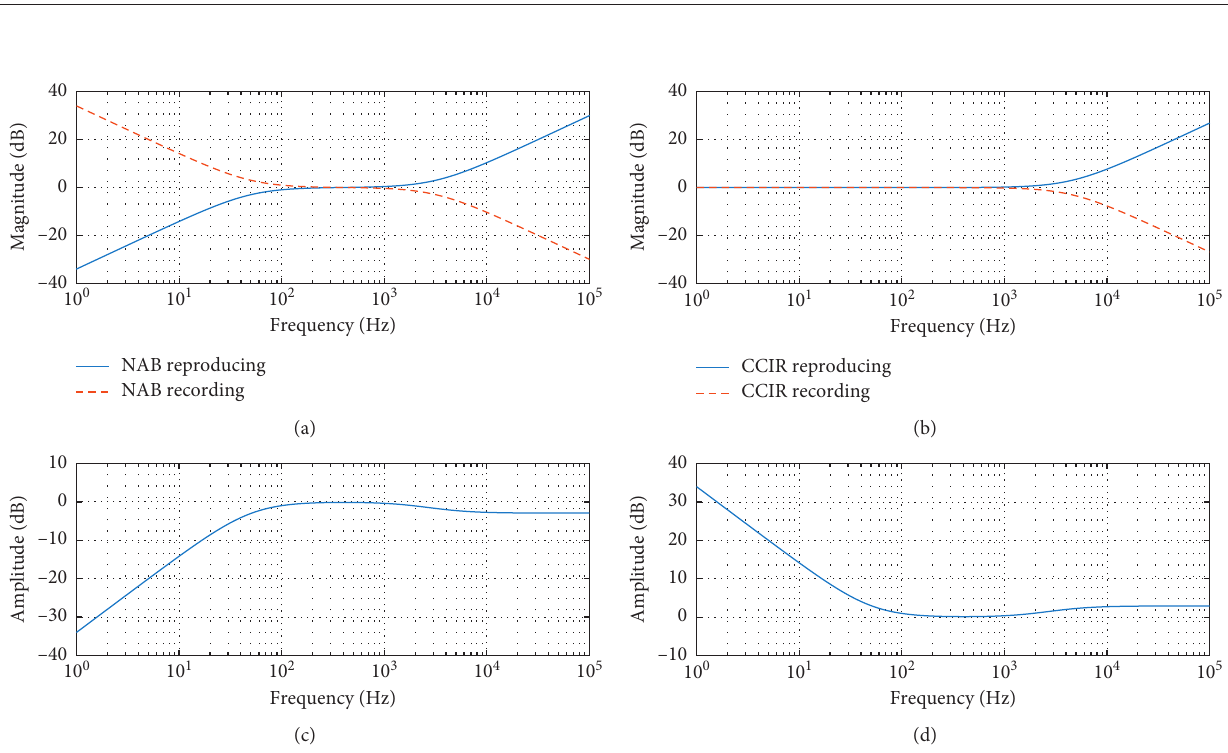
Figure 1: Plots of the frequency response of NAB and CCIR pre- and postemphasis curves, respectively (a, b) and the filers for compensating the incorrect juxtapositions: NAB-CCIR (c) and CCIR-NAB (d). (a) NAB equalization. (b) CCIR equalization. (c) Filter for the NAB-CCIR correction. (d) Filter for the CCIR-NAB Table 2: Time constants of the considered cases: in the stable one, W (parameters t used CCIR values; in the unstable one, W used CCIR values, but 􏽥 R used NAB values. Time constant Stable ( μ s )